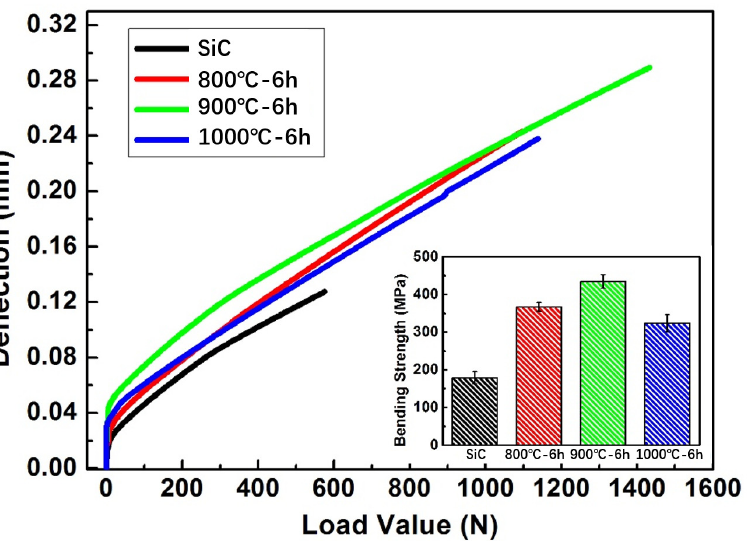
Figure 14. Load-deflection curves and three-point bending strength of SiC ceramics and SiC infiltrated at 800, 900, and 1000 °C for 6 h.